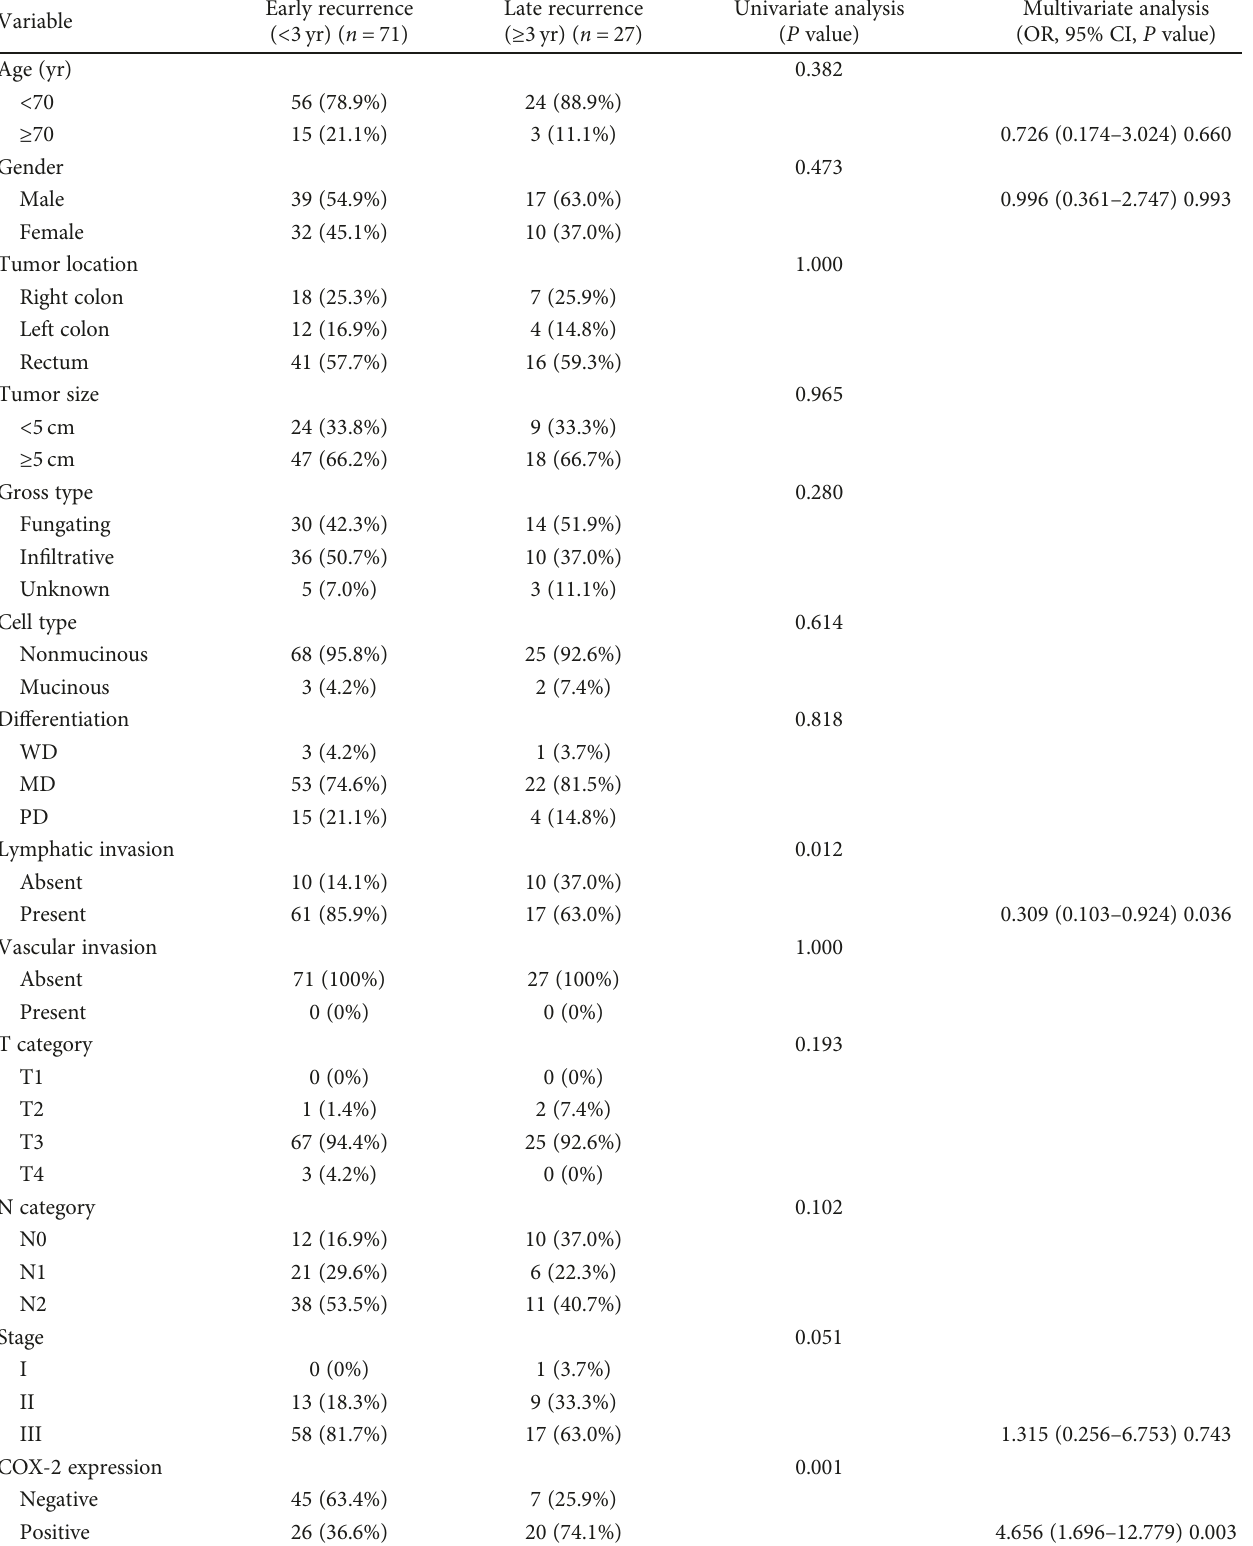
Table 3: Univariate and multivariate analysis of independent risk factors associated with late